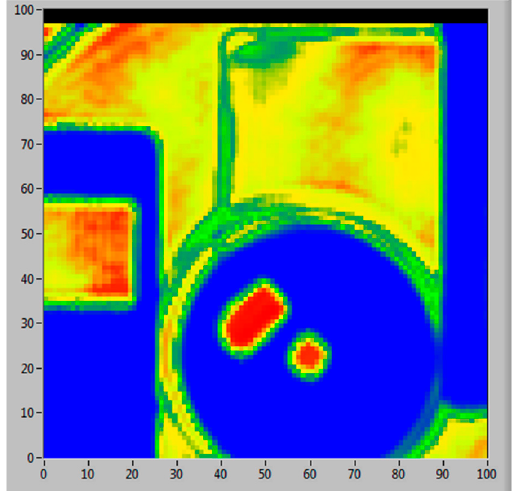
Figure 10. The THz transmission image of the computer disk acquired using the TTL electronic signal modulation at the same chopper speed of 1 kHz and scanning conditions as that used in Figure 4 image modulated with an optic chopper.